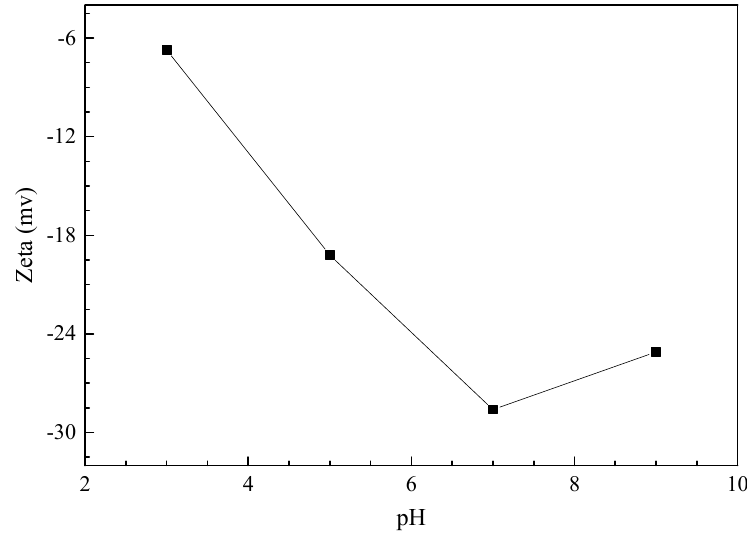
Figure 7. Zeta potentials of the modified peat.